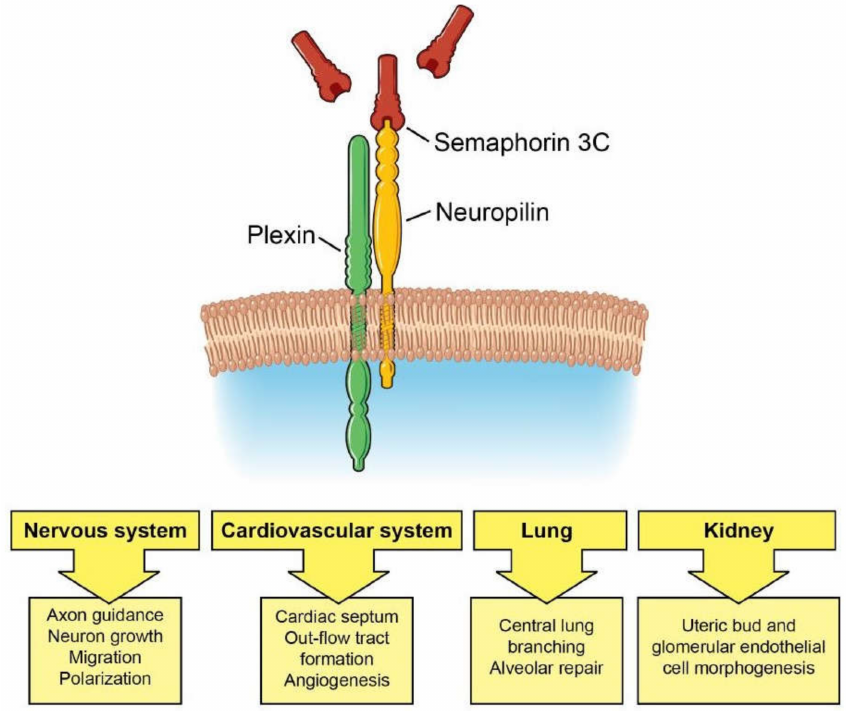
Figure 1. Sema3C/Neuropilin/Plexin signaling in development. Sema3C signaling guides development of the nervous and cardiovascular systems, lung, and